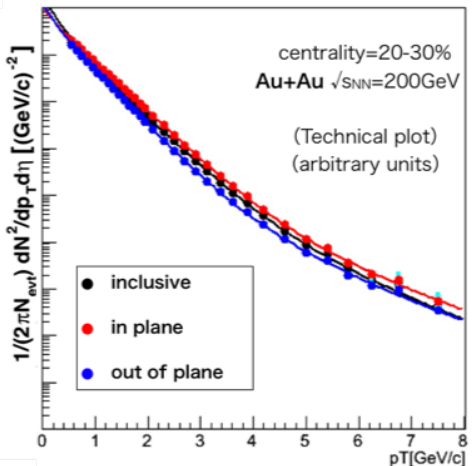
Figure 2. Inclusive, in-plane and out-of-plane yields as a function of p T for the centrality 20–30% in the √ s NN = 200 GeV. Bars indicate the statistical Au + Au collisions at